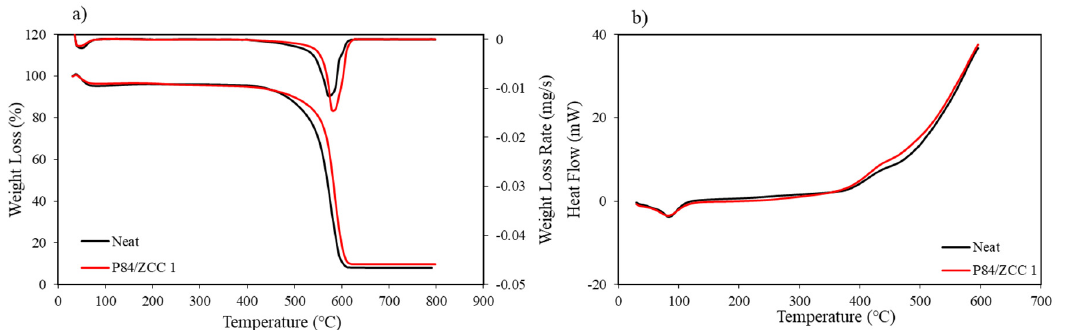
Figure 5. TGA ( a ) and DSC ( b ) curve of all prepared membranes.